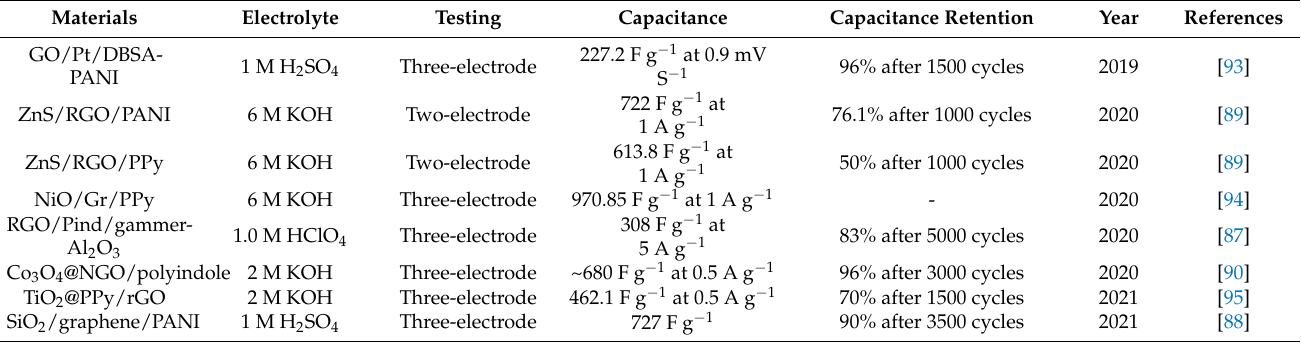
Table 2. Electrochemical performance of some previously reported ternary